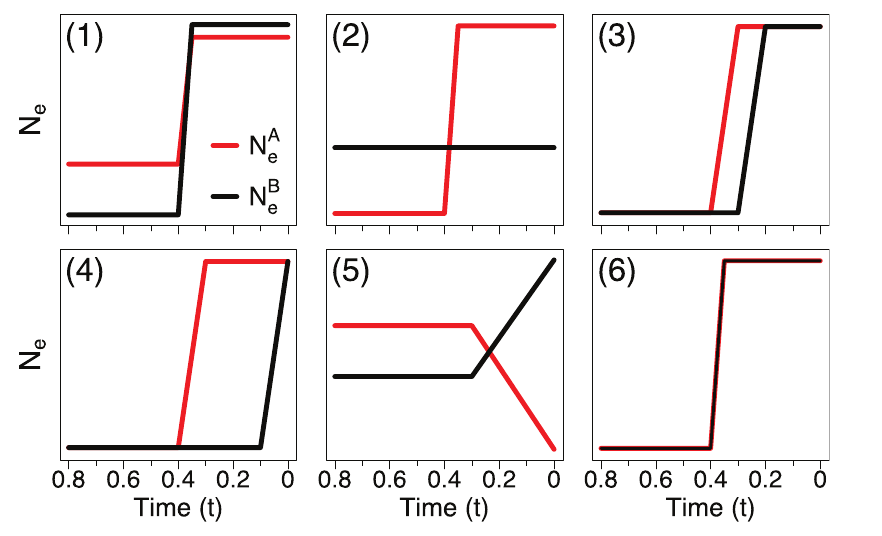
Fig 3. Population trajectories for synthetic data.